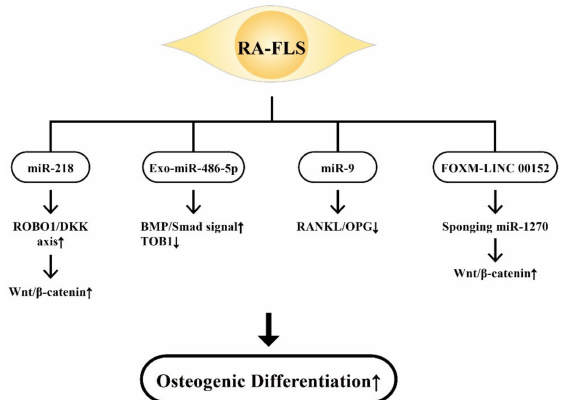
Figure 9. The beneficial effect of RA-FLS-released ncRNAs including miR-218, Exo-miR-486-5p, miR-9, and FOXM-LINC 00152 with their target molecules on the osteogenic differentiation. In- creased expression of the ROBO/DKK axis, BMP/Smad signaling and Wnt/ β -catenin signaling, and decreased RANKL/OPG ratio are positive for bone regeneration. ROBO1: roundabout guidance receptor 1, Smad: small mother against decapentaplegic protein, BMP: bone morphogenetic protein, DKK: Dickkopf, ↑ : Increase, ↓ :